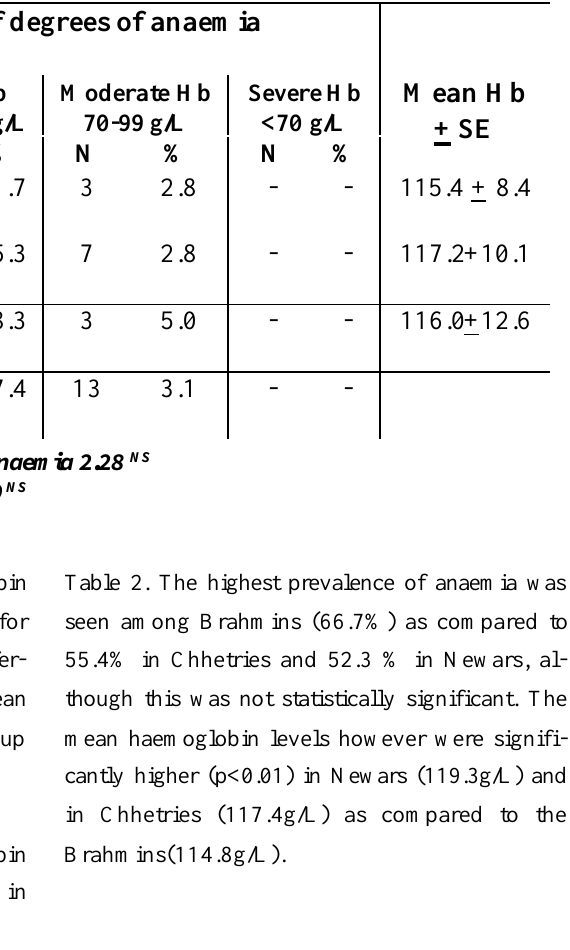
Prevalence of degress of anaemia in subjects studied by age group (N=420)